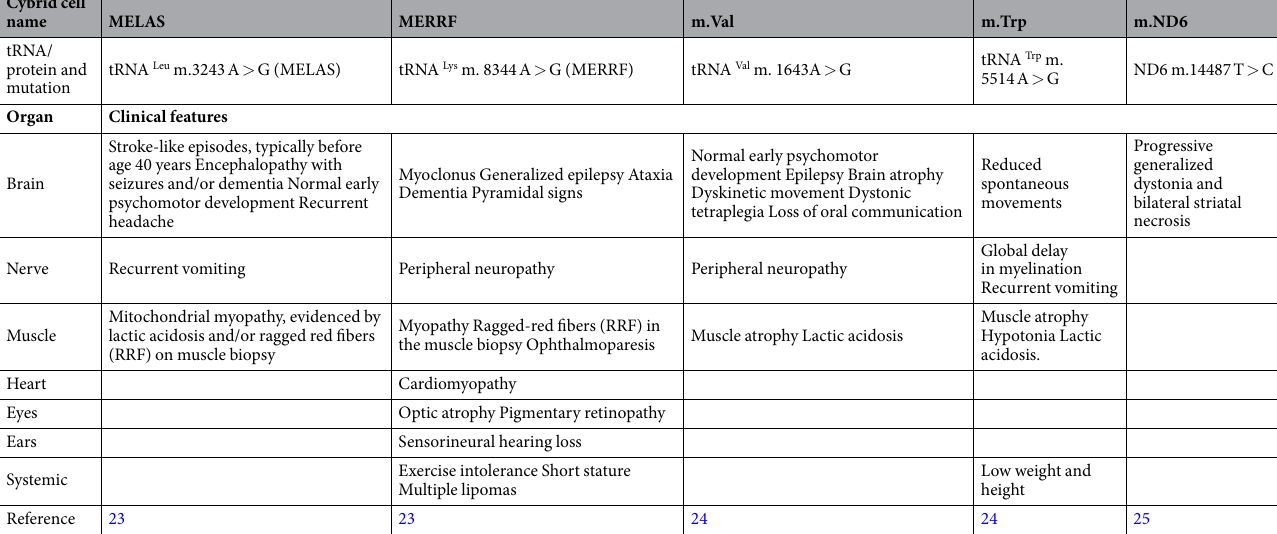
Table 1. Brief summary of clinical symptoms associated with each